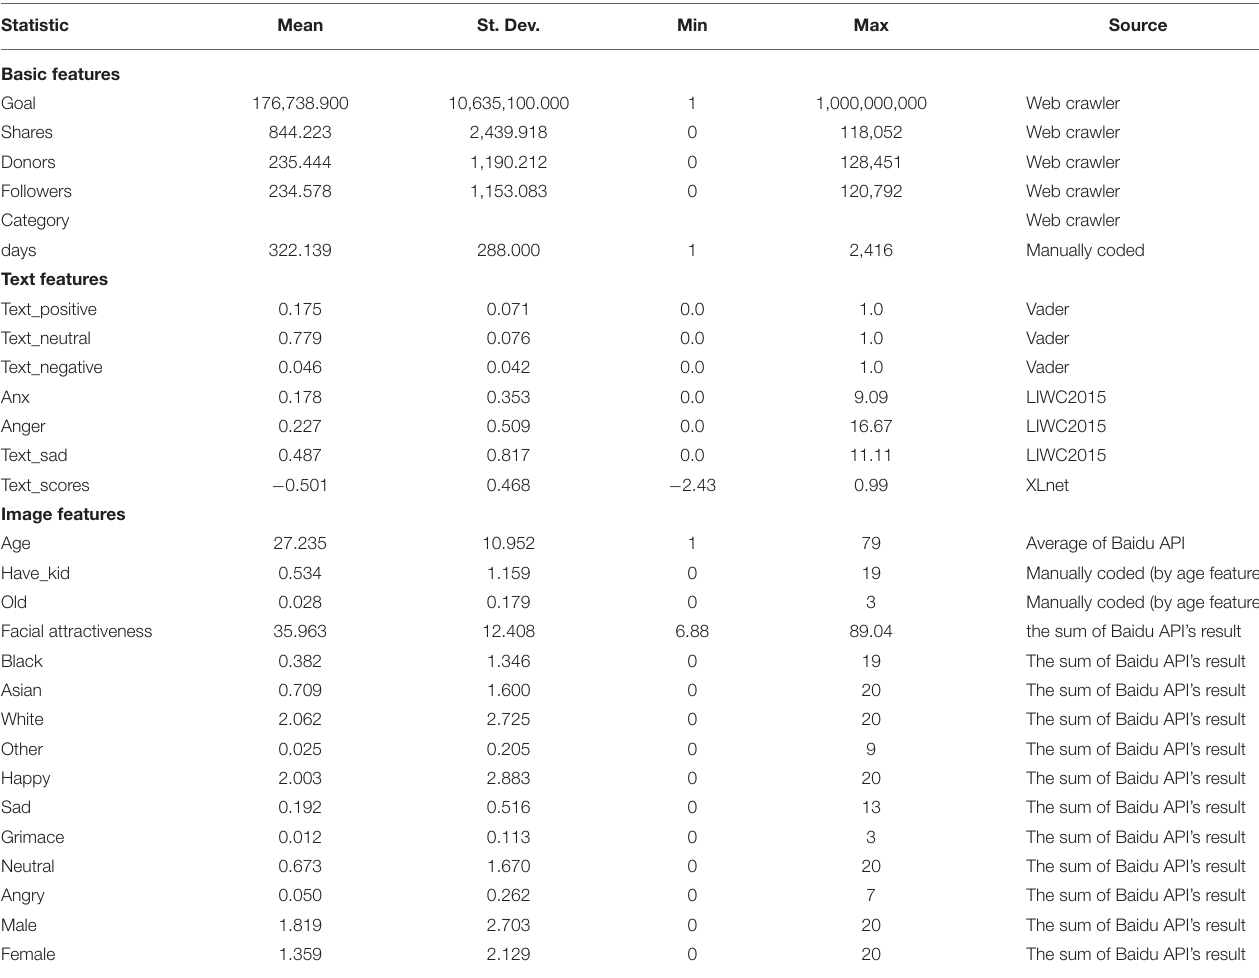
TABLE 1 | Sources of (inferred)